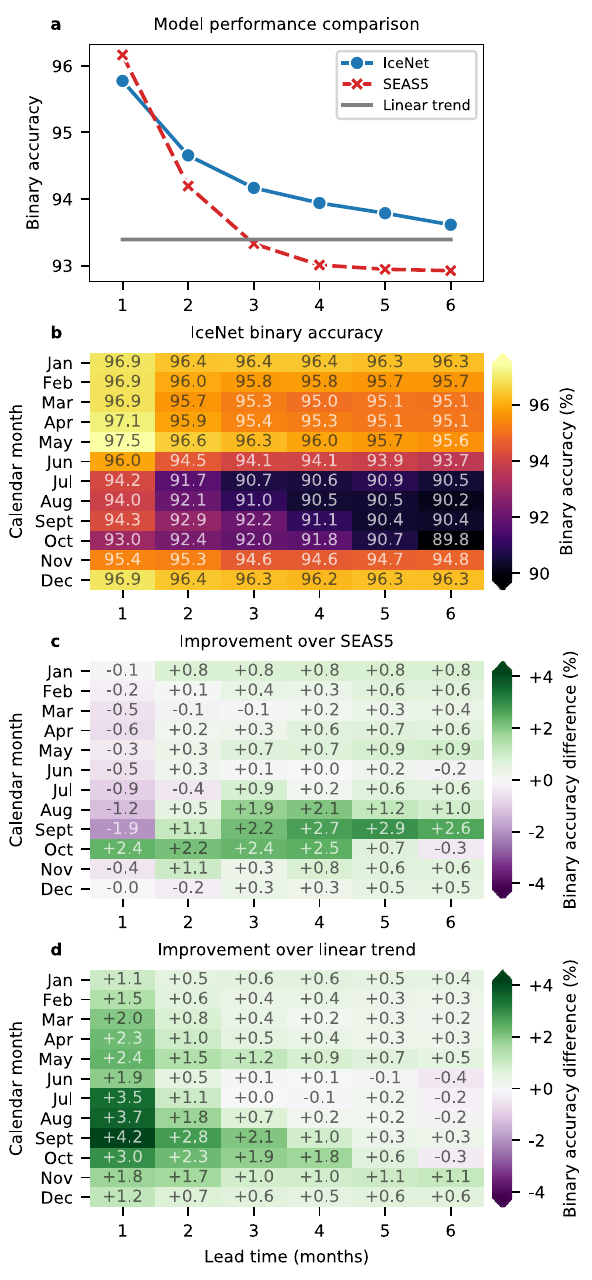
Fig. 3 Comparing IceNet with dynamical and statistical prediction benchmarks. a Mean binary accuracy versus lead time over the validation and test years (2012 – 2020) shown for IceNet, SEAS5, and the linear trend model. b IceNet ’ s binary accuracy averaged across the validation and test years, shown for each forecast calendar month and lead time, with the heatmap values shown within each grid cell. c , d Heatmaps of the difference between b and the equivalent heatmaps of SEAS5 and the linear trend model respectively, illustrating IceNet ’ s improvement over those